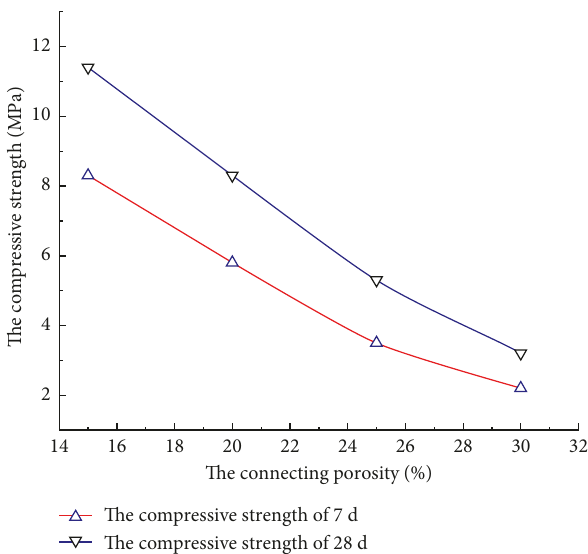
Figure 15: Relationship between connected porosity and com- pressive strength.